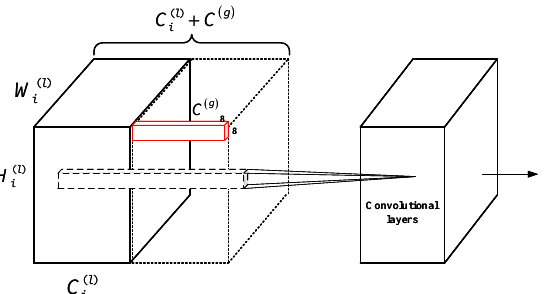
( l ) ( l ) ( l ) , H and C respectively i i i